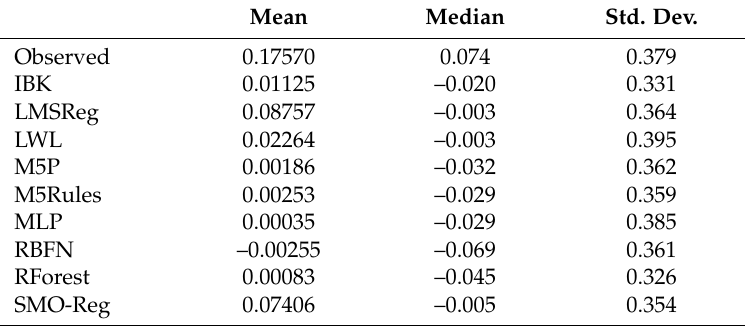
Table 5. Comparison between model-based and actual underpricing on the test set. Model-based underpricing is based on the forecasted first-day close price instead of the offer price. Average values are of the statistics on the test data over 15 runs.